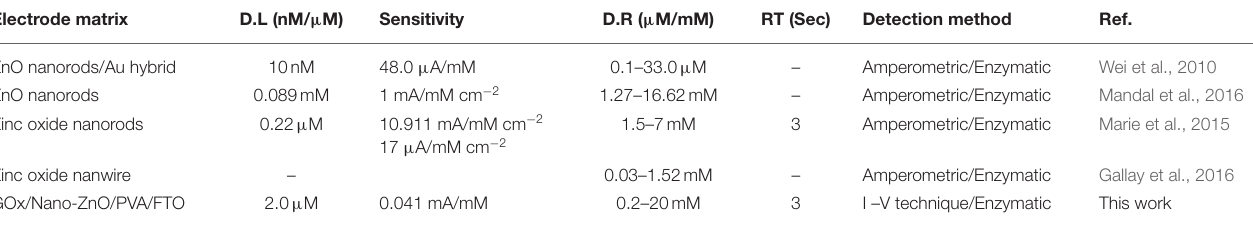
TABLE 2 | Analytical characteristics GOx/Nano-ZnO/PVA/FTO biosensor compared with the other reported ZnO base glucose biosensors. Electrode